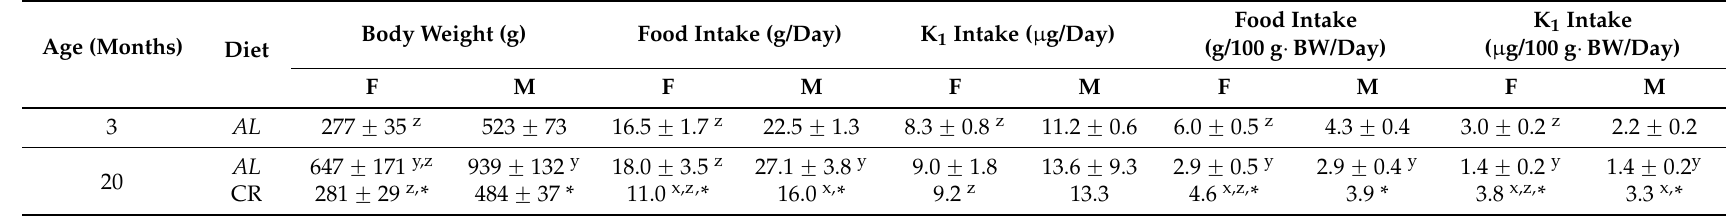
Table 3. Body weights, daily food (g/day and g/100 g ¨ BW/day), and K 1 ( µ g/day and µ g/100 g ¨ BW) intakes of 3- and 20-month-old M and F Sprague–Dawley rats fed an ad libitum ( AL ) or calorie restricted (CR)